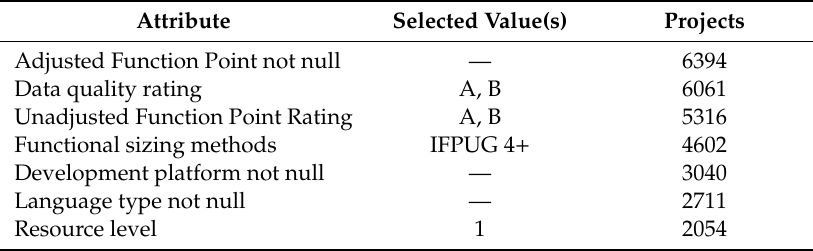
Table 3. Criteria for selecting the data sets from the ISBSG (8261